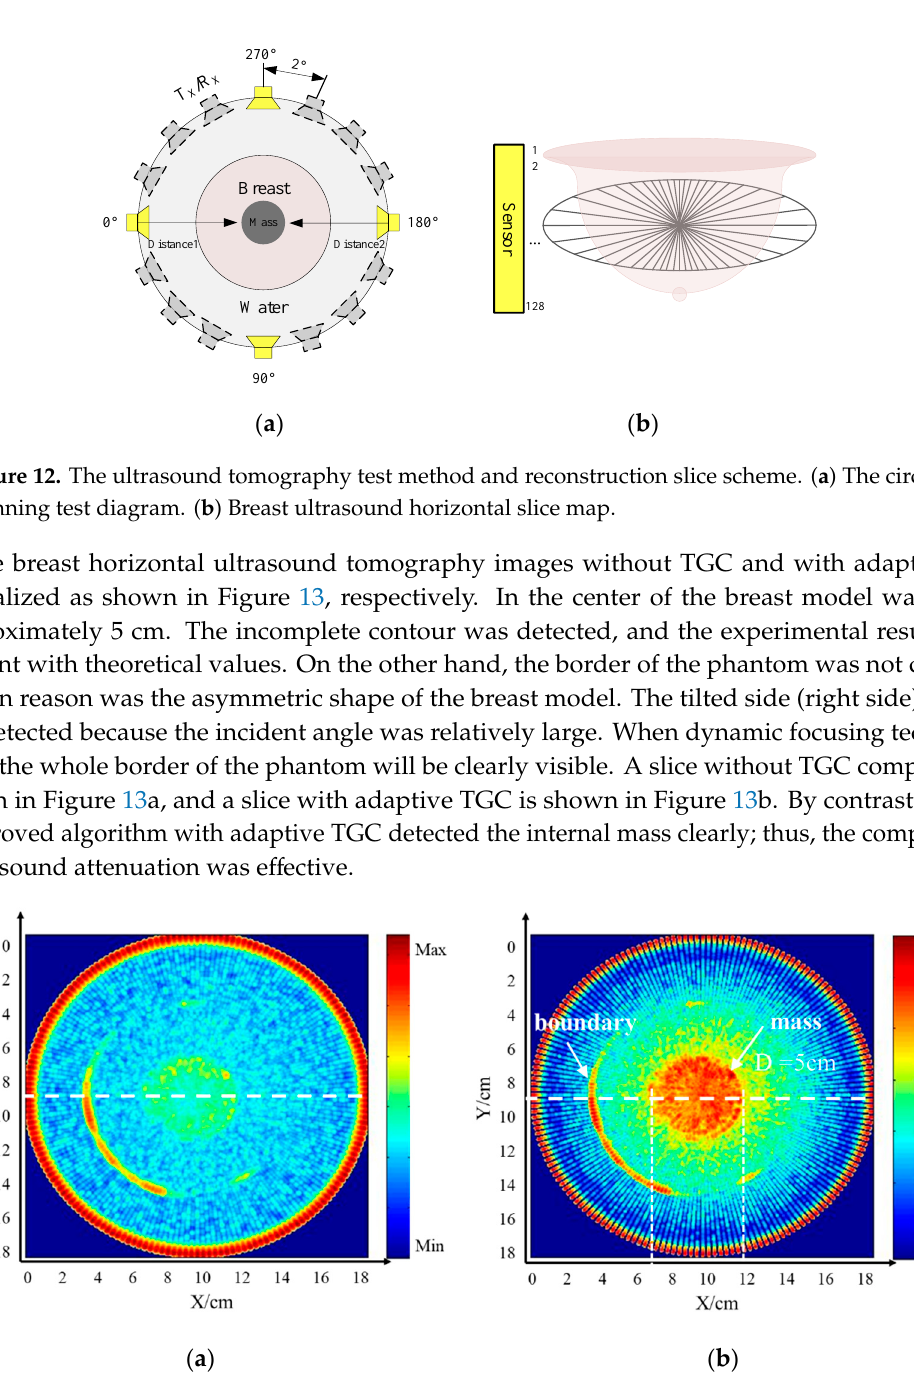
Figure 13. Horizontal ultrasound tomography image: ( a ) without TGC, ( b ) with adaptive TGC.